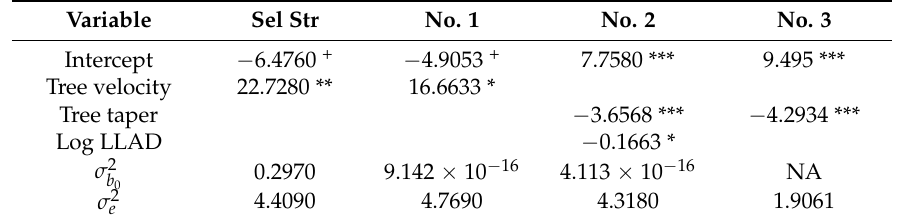
Table 9. Selected parameters and level of significance for lumber structural grade abundance models.